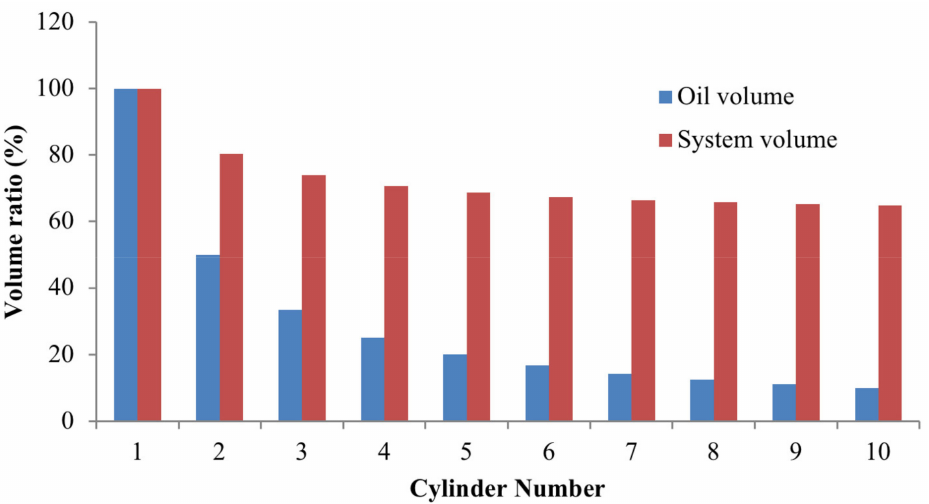
Figure 6. The system and oil volume ratio of OHESS to regular hydraulic ESS